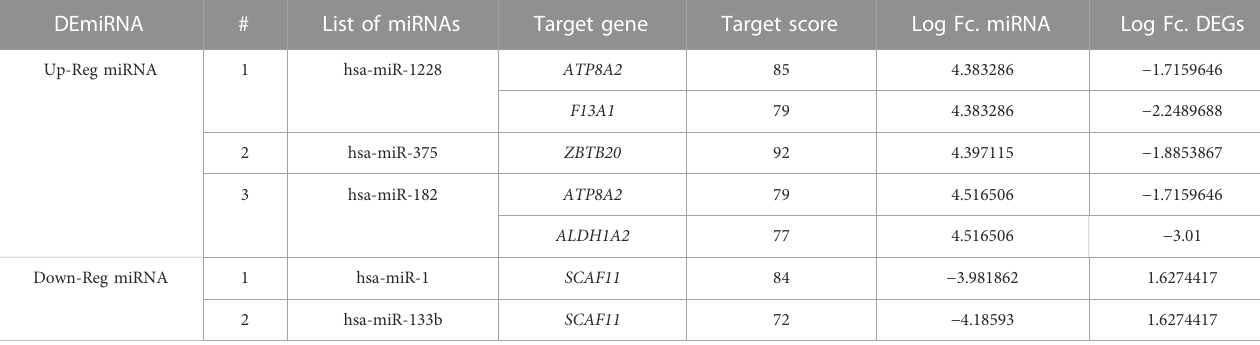
TABLE 2 The DEmiRNA-target gene pairs in endometrial cancer tissues.